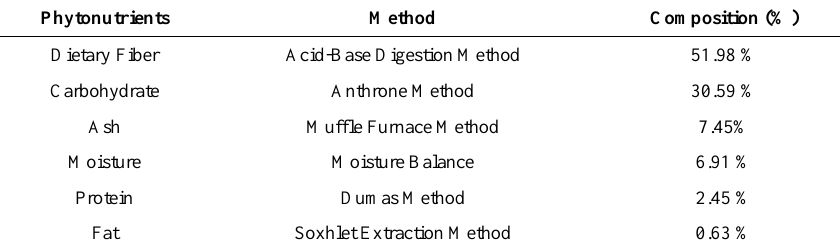
Table 3. Estimation of phytonutrients of stem barks of Phyllanthus Albizzioides